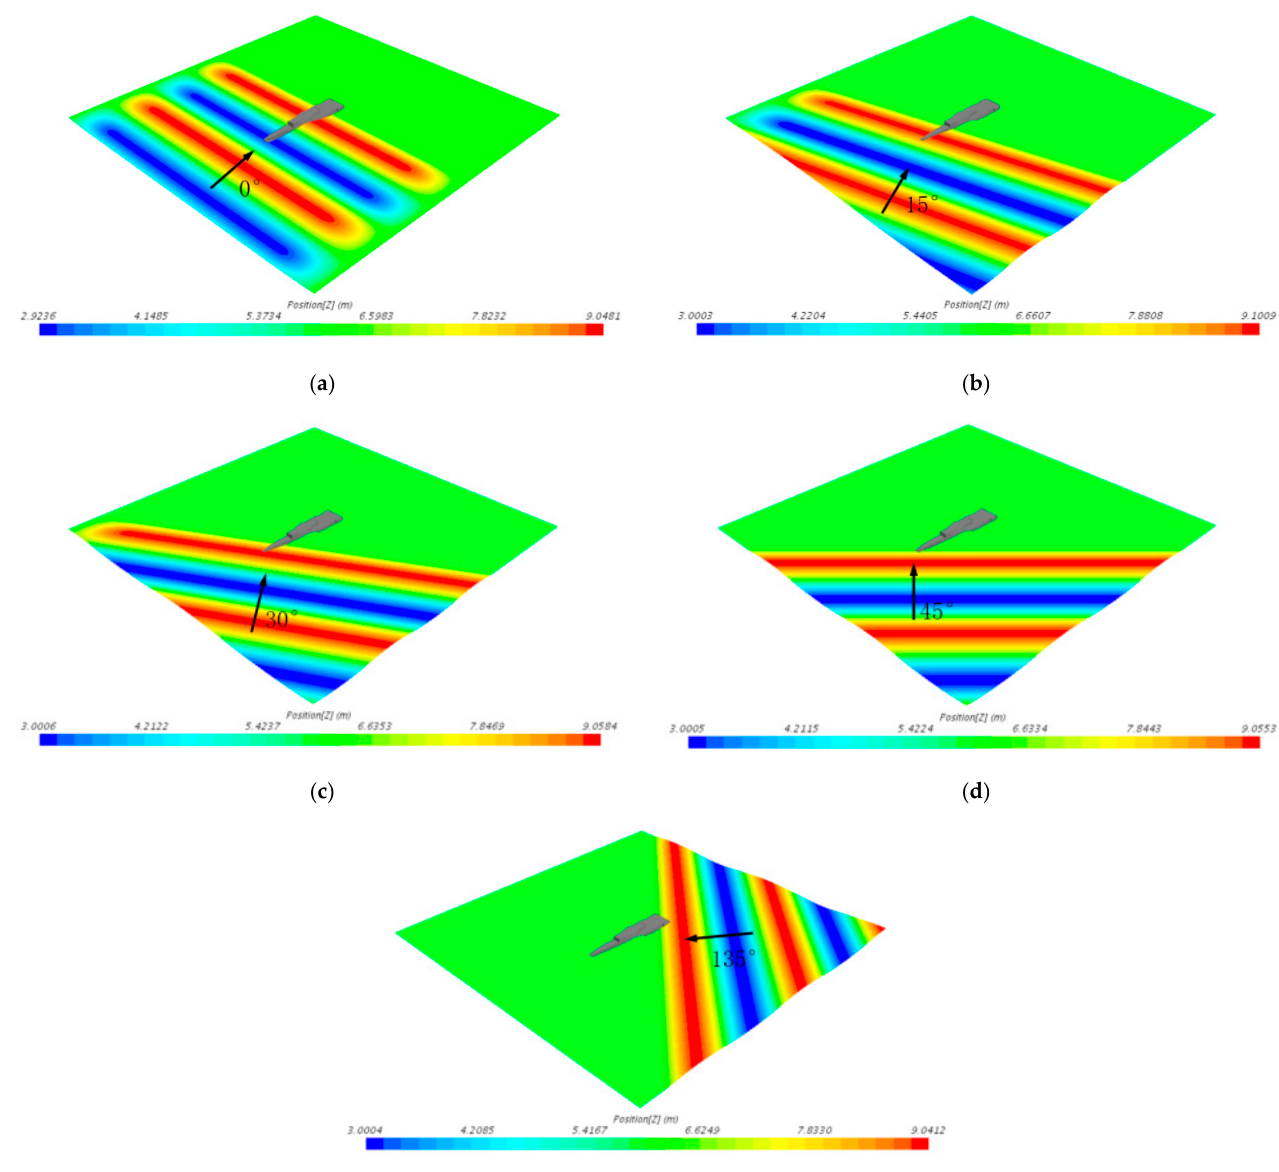
Figure 10. Initialized wave profile. ( a ) θ = 0 ◦ ; ( b ) θ = 15 ◦ ; ( c ) θ = 30 ◦ ; ( d ) θ = 45 ◦ ; ( e ) θ = 135 ◦